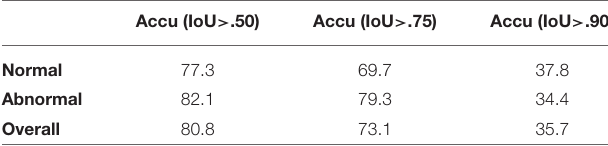
where { a ( x ) } represents the set of frame level anomaly scores for all frames in the given video s .